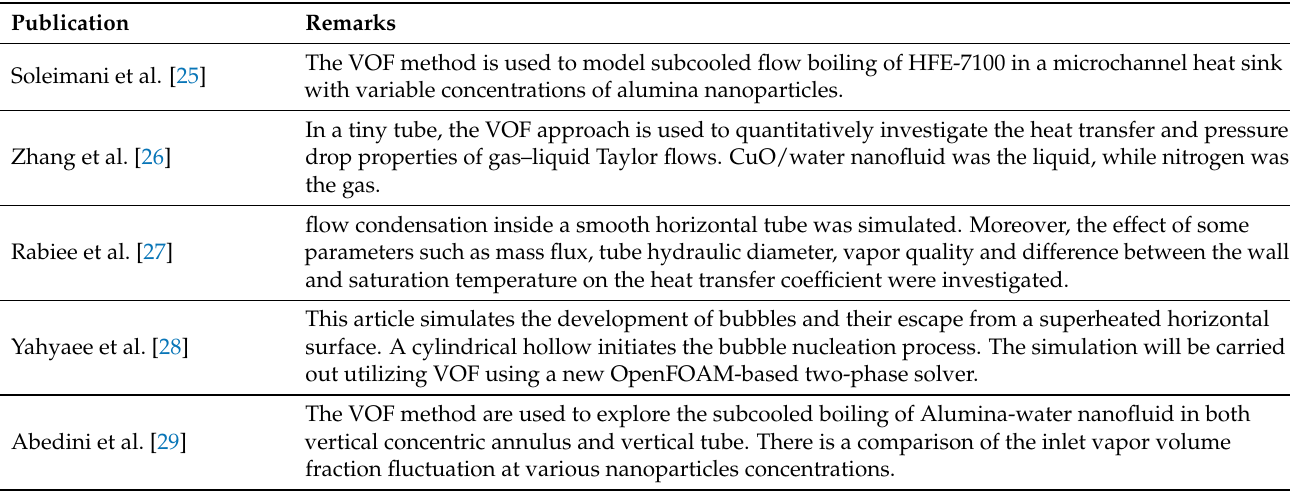
Table 1. An overview of some of the studies that have used VOF as their interface capture technique is shown in the next section. The scope of these simulations is restricted to thermally induced phase transitions or flow boiling of nanofluids